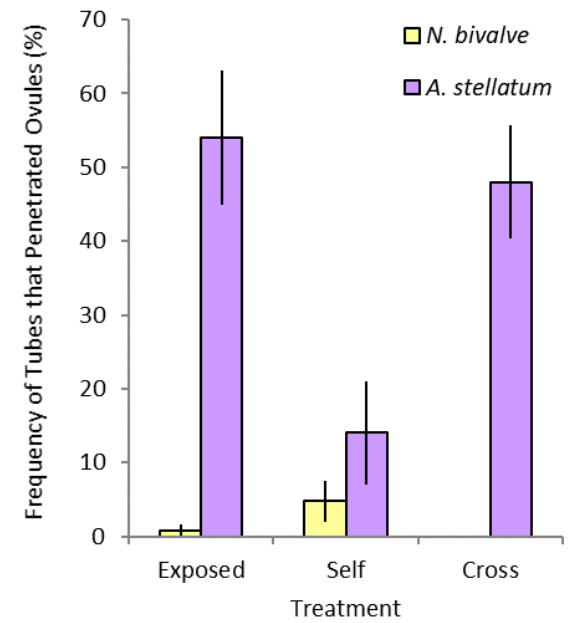
F IGURE 9. Percent of ovules penetrated by tubes compared to the number of pollen tubes per style. In N. bivalve, no tubes in cross- pollinated flowers penetrated ovules. Error bars are standard error of the mean.